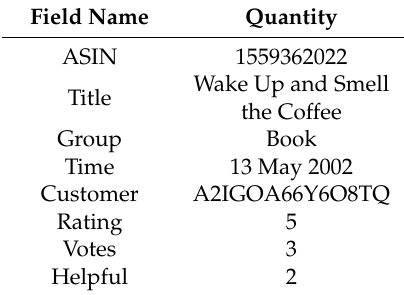
Table 1. The structure of data records.